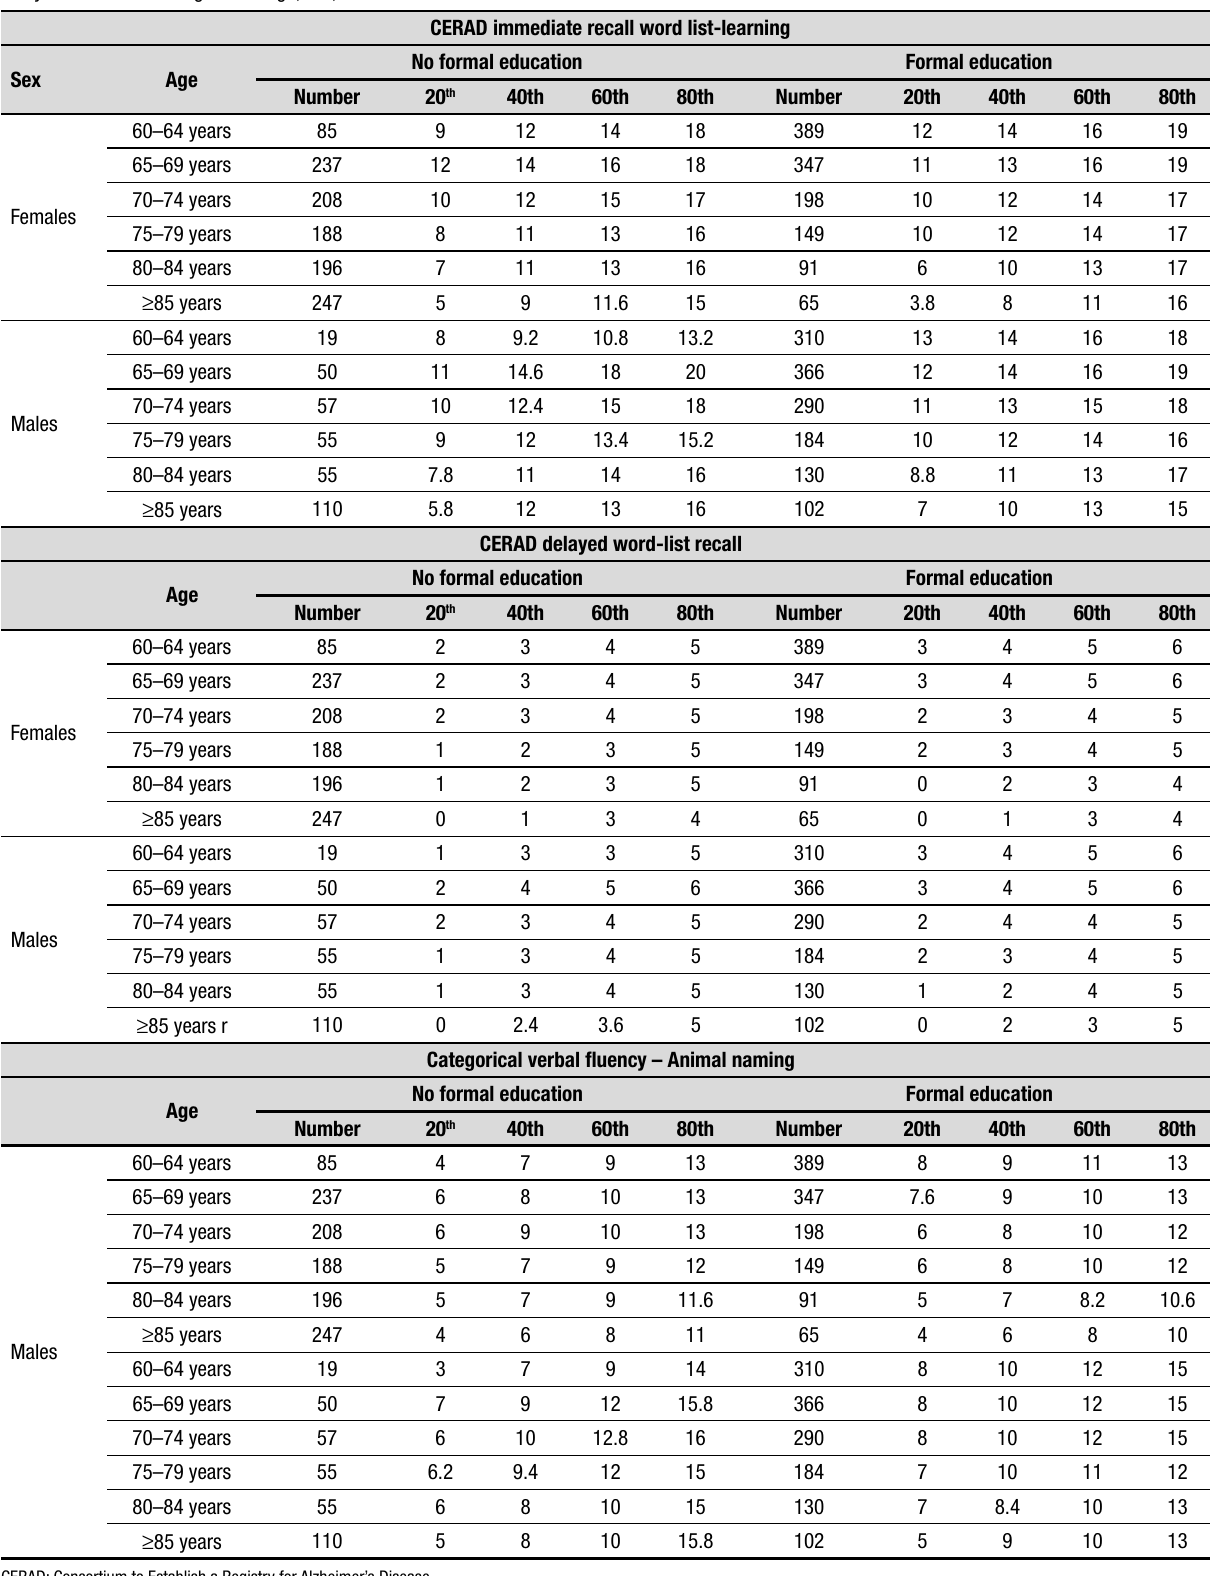
Table 3. Quintiles for the Consortium to Establish a Registry for Alzheimer’s Disease word list such as immediate recall, delayed recall, and animal naming all by the combined categories of age, sex, and